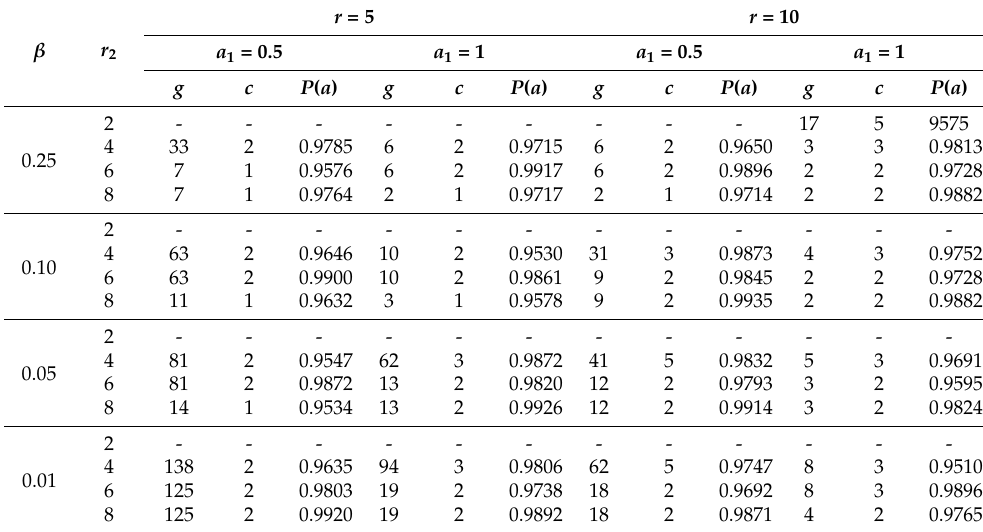
Table 3. GASP for MLE ˆ a = 0.94, ˆ b = 1.14, and ˆ α = 0.63, showing minimum g and c